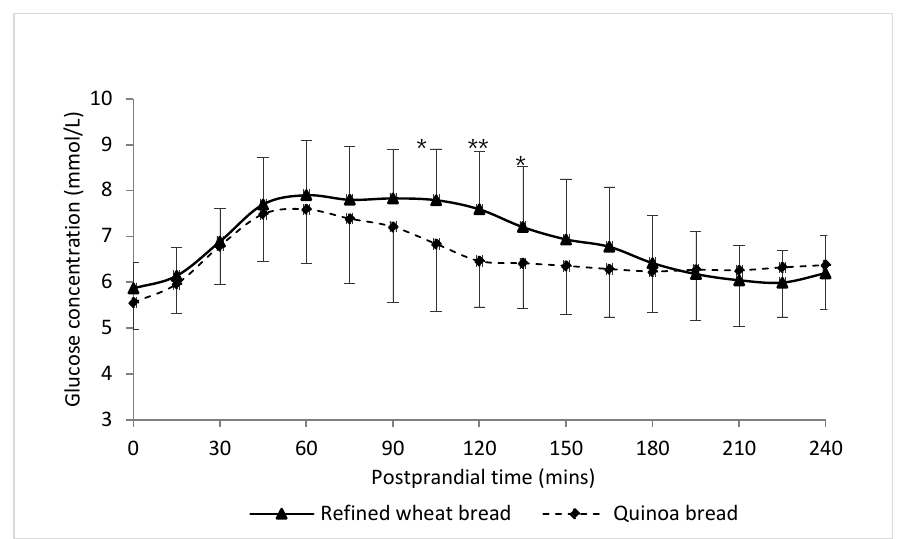
Figure 4. Mean concentrations of glucose responses for 240 min after intake of refined wheat bread and quinoa bread meals after 4 weeks of intervention measured by continuous glucose monitoring. Values are means with their standard deviations represented by vertical bars ( n = 24 for refined wheat bread treatment and quinoa bread treatment). * Mean values were significantly different between meals: * p < 0.05, ** p < 0.01 (paired-samples t test with Bonferroni correction).